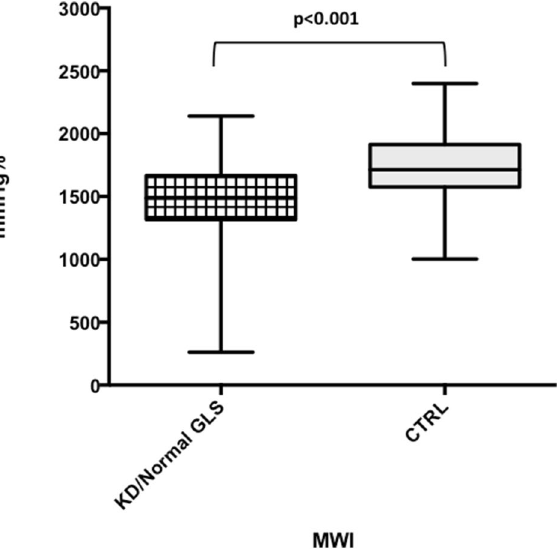
Figure 4. KD/CADL patients with normal GLS presented significant differences in MWI values compared to controls. Graphs in this figure were drawn by using Past software (version